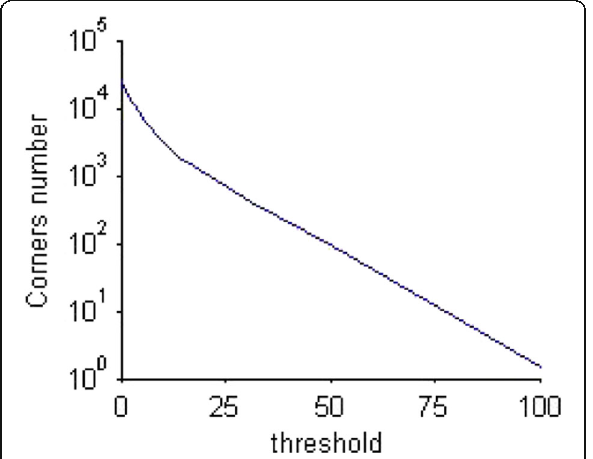
Fig. 5 Graphs of the corners number and the threshold ε d